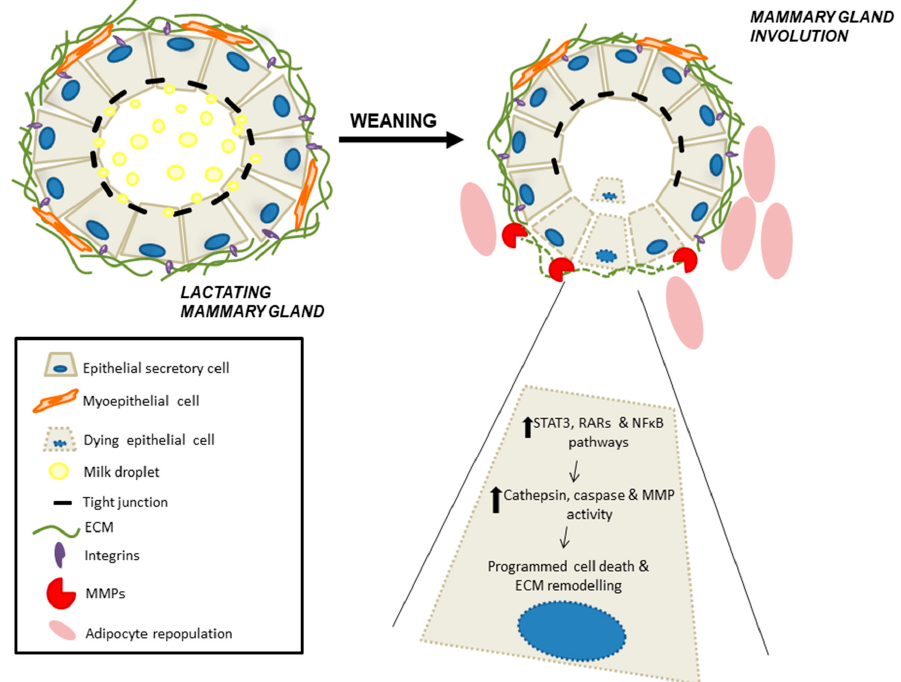
Figure 2. Schematic model of mammary gland involution. Lactation is characterized by an alveolar architecture lined by secretory mammary epithelial cells and contractile myoepithelial cells underneath. After weaning, milk stasis within the lumen and other local factors initiate involution of the mammary gland. At this point, cell shedding and cell death (cells with dotted lines) begins by 12 h after milk stasis, but lactation is still reversible until 48 h of weaning. Beyond this time point, epithelial tight junctions are disrupted, followed by extracellular matrix (ECM) remodeling and adipocyte re-differentiation [68,70,72,73]. MMP, metalloprotease; RAR, retinoic acid receptor; STAT3, signal transducer and activator of transcription 3; NF-kB, nuclear factor kappa B.